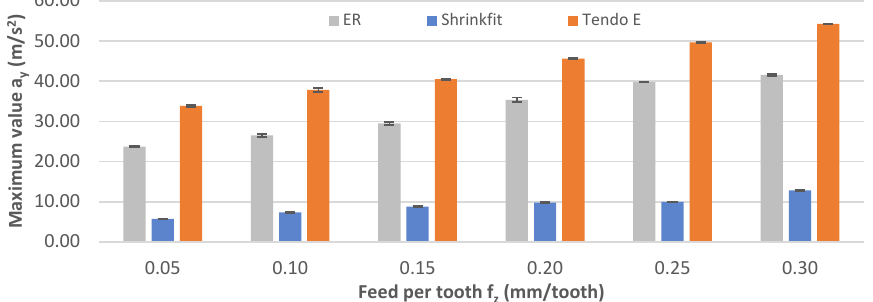
Figure 15. Impact of feed per tooth f z on the maximum vibration acceleration value a y (v c = 800 m/min, a p = 6 mm). The impact of the feed per tooth change on vibration acceleration amplitude Aa y is shown in Figure 16. The reported values increased over the entire range of the feed per tooth change, regardless of the tool holder used. The amplitude values were in the range 2.89 – 6.48 m/s 2 , 11.97 – 20.97 m/s 2 , and 17.12 – 27.48 m/s 2 for the heat shrink, ER, and hydrau- lic holders, respectively.